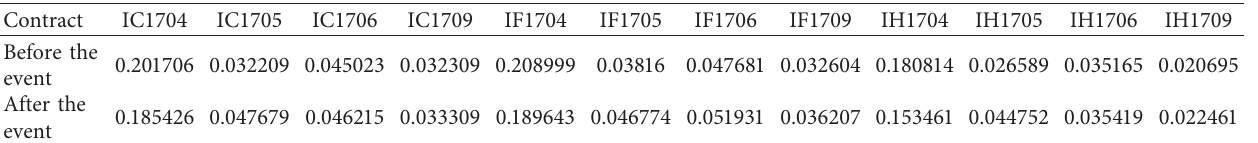
Table 8: The probability of informed trading for IC, IF, and IH